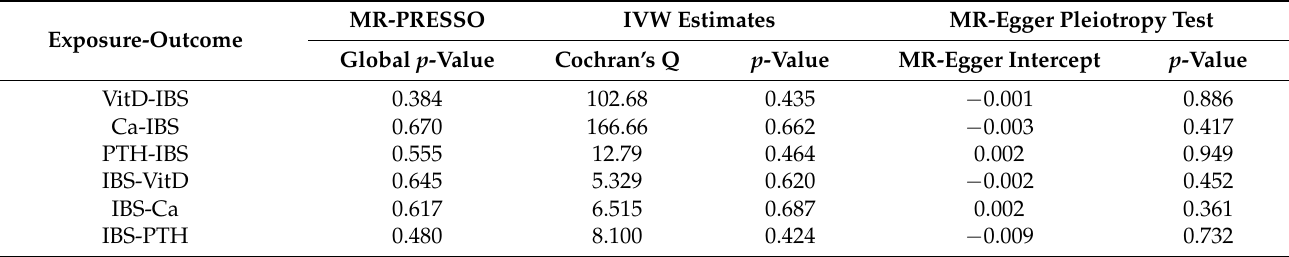
Figure 2. The result of MR analysis investigating the causality between IBS and VitD, Ca, and PTH using multiple approaches. VitD, 25-hydroxyvitamin D; Ca, calcium; PTH, parathyroid hormone; IBS, irritable bowel syndrome; OR, odds ratio; 95% CI, 95% confidence interval. Table 2. The result of sensitivity analyses of MR.